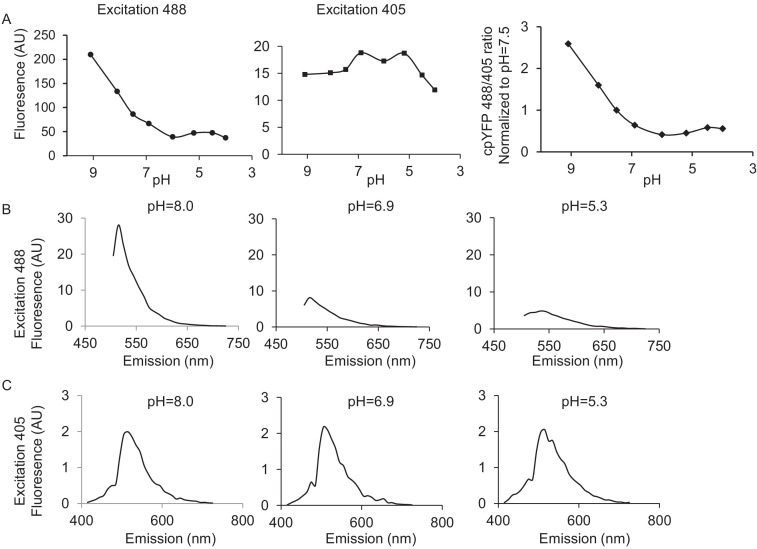
pH calibration of mt-cpYFP in adult cardiac myocytes with Nigericin.10 μM Nigericin was added to the mitochondrial permeabilization buffer. (A) shows the pH calibration of 488 nm and 405 nm, the ratio of 488/405 (normalized to that of the value at pH = 7.5) as the pH is gradually lowered. The ratio of 488/405 reaches the lowest point at pH 6.0, followed by a small increase starting at pH 5.5, consistent with the known pH response of this dye (Wei-LaPierre et al., 2013). (B) shows the emission spectra of mt-cpYFP pH 8.0, 6.9, and 5.3 when excited at 488 nm (C) shows the emission spectra of mt-cpYFP pH 8.0, 6.9, and 5.3 when excited at 405 nm. The 488 nm excitation is sensitive to the pH change but the 405 nm excitation is much less pH dependent.